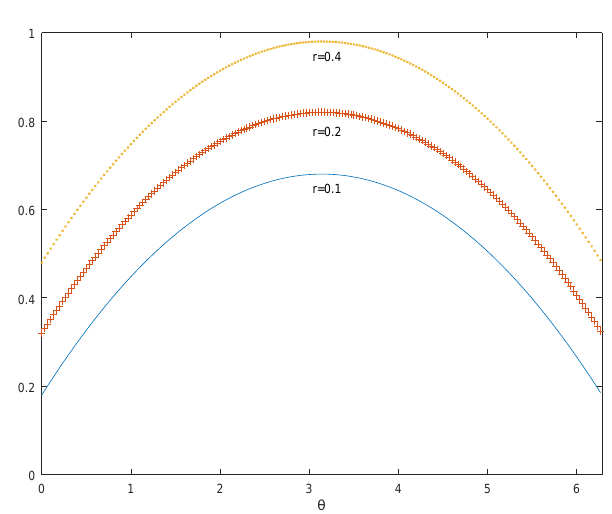
Figure 5. Vertical section of Figure 4.